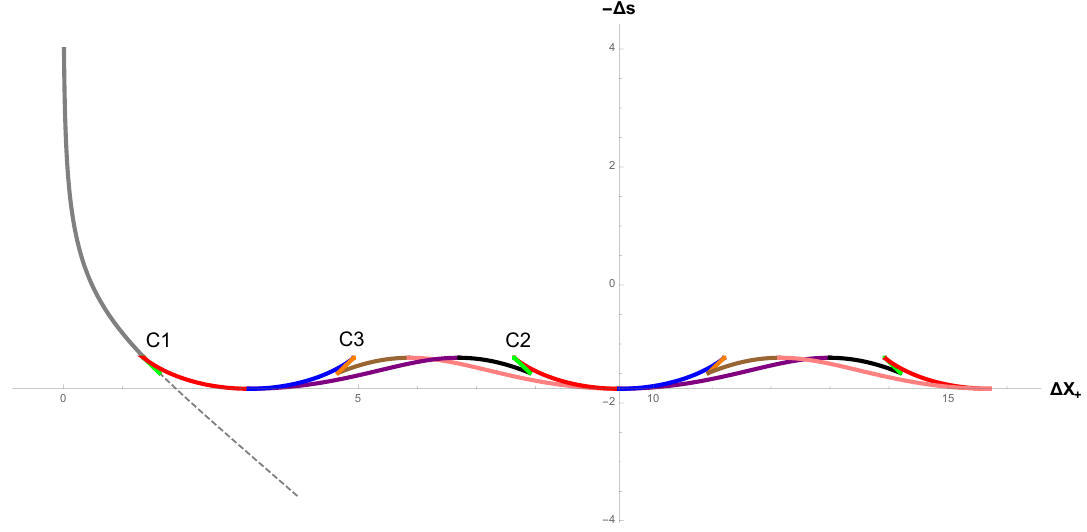
Figure 6 . All branches of geodesic length as function of (cid:1) X + for M = 1 and u (cid:3) = 0 : 95. The initial gray line on the left is due to the thermal geometry before the geodesic crosses the shell. The dashed line represents how the thermal behaviour would continue without the presence of the shell. (cid:12)gure